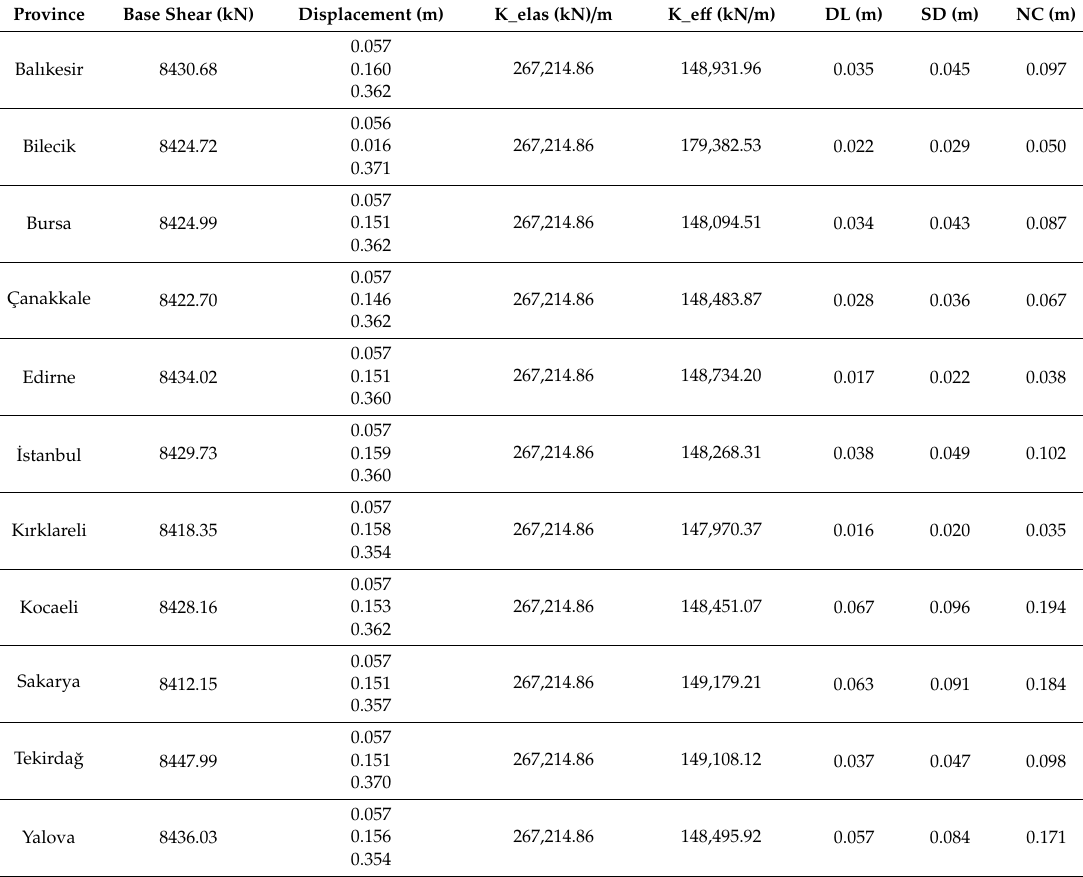
Figure 13. Comparison of pushover curves for 6-story. Table 8. Comparison of values obtained in X direction for 3-story building.